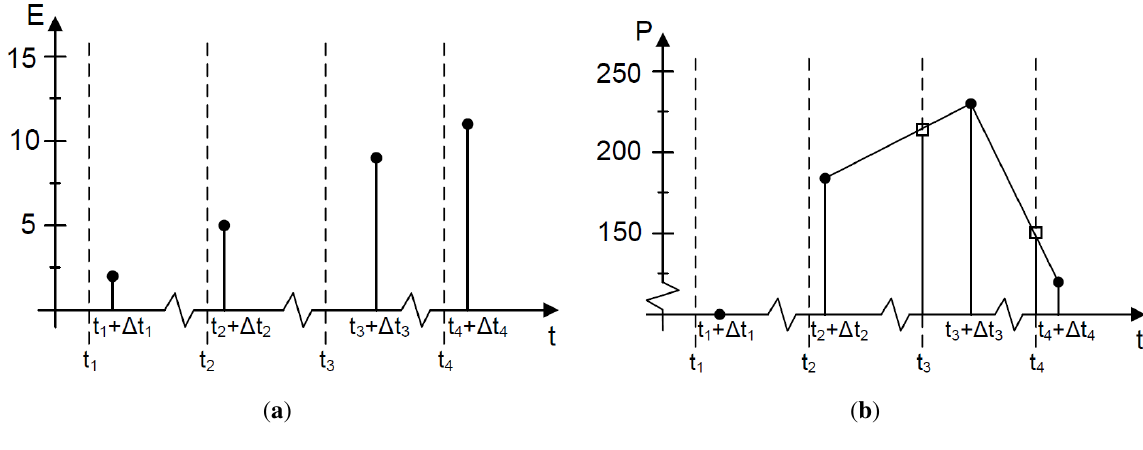
Figure 4. Meter data handling: ( a ) Energy measurement; and ( b ) power